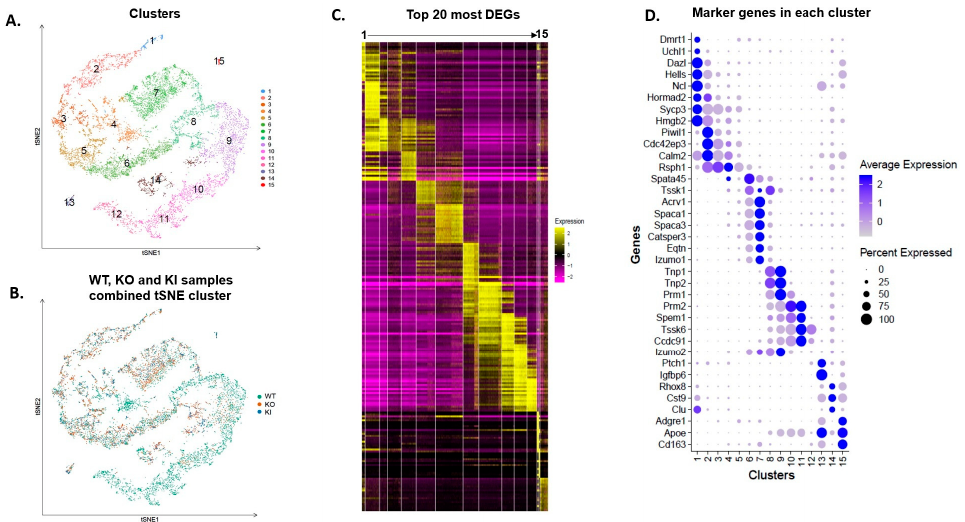
Figure 1. Single-cell transcriptomic profiling of testicular cells from adult WT, KO and KI mice. ( A ) tSNE plot shows profiling/clustering of testicular cells from combined libraries of WT, KO and KI. Each dot represents a single cell and is colored according to its cluster identity. ( B ) tSNE plot of single-cell transcriptome data with cells colored based on their sample/library of origin. ( C ) Heatmaps show the top-20 significantly differentially expressed genes (DEGs) between each cell cluster. ( D ) Dot plot analysis of characteristic marker genes based on cluster ID.